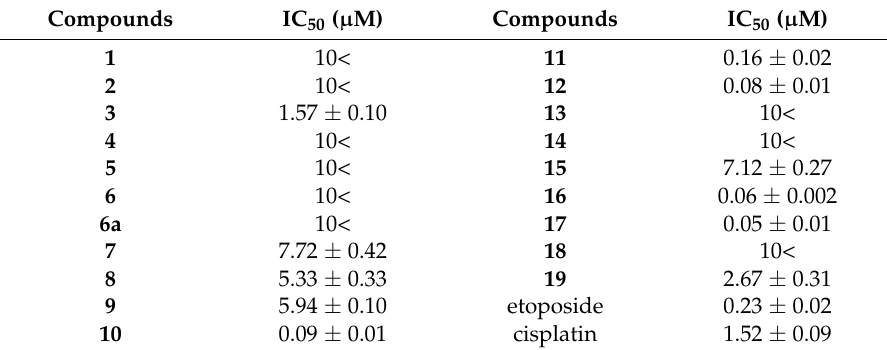
Table 4. Cytotoxic activities of 1 – 19 , 6a , etoposide, and cisplatin against HL-60 cells a .